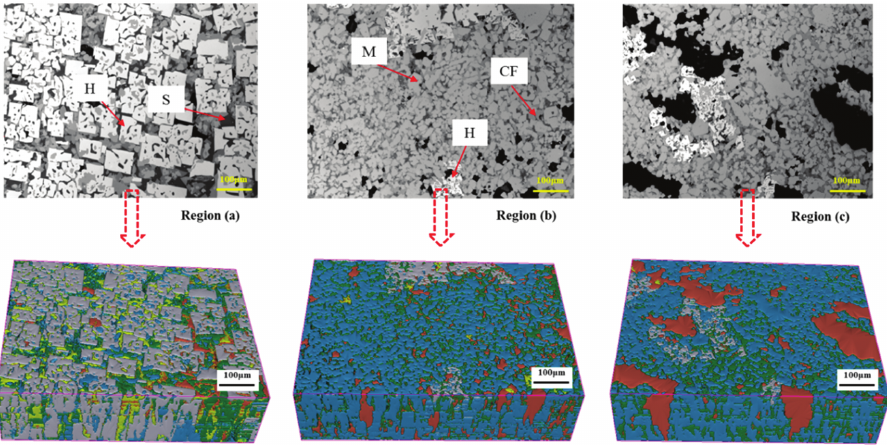
Figure 2: 2D and 3D images of selected regions in vanadium-titanium sinter.